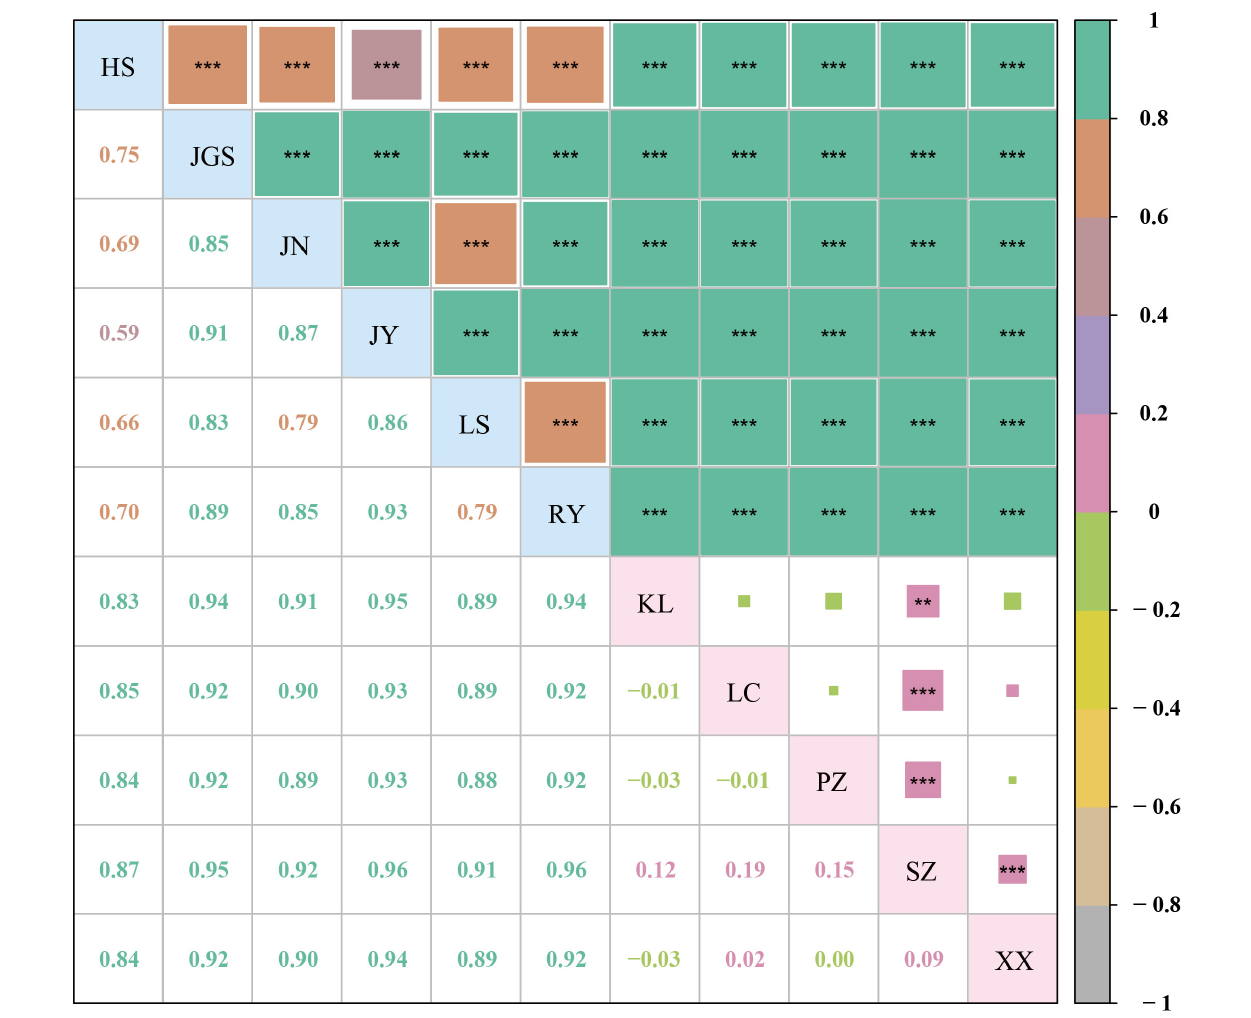
FIGURE 5 | Pairwise Fst values among 11 subpopulations of C. chinensis . The letters on the diagonal represent 11 subpopulations of C. chinensis . Below the diagonal, the number in the box is the pairwise Fst value between a vertical subpopulation and a horizontal subpopulation. Above the diagonal, pairwise Fst value is reflected by area and color of the square. The higher the Fst value is, the larger the colored area is. The color referring to the Fst value range is indicated in the column chart on the far right. The P -value is the probability calculated via significance test. ** indicates P < 0.01, *** indicates P < 0.001.